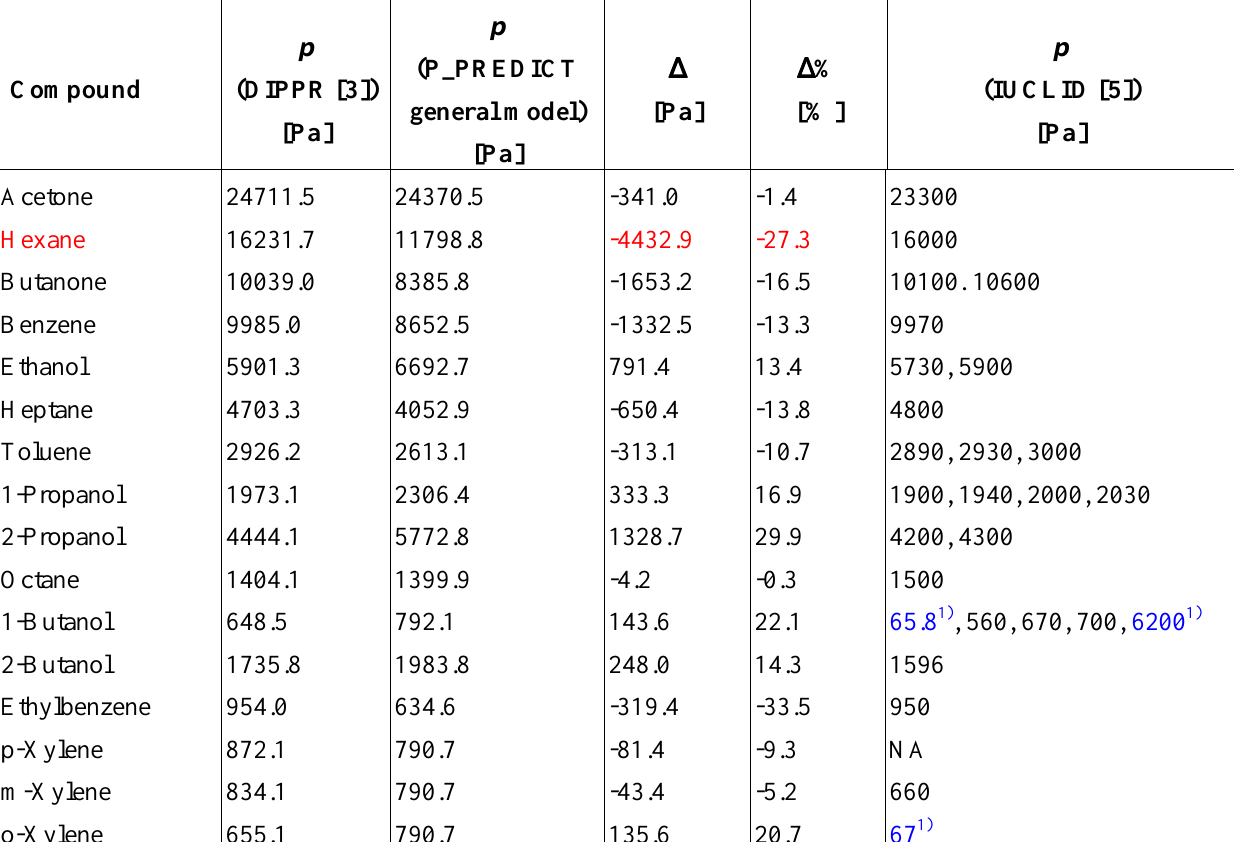
Table 5. P_PREDICT predictions versus “true” vapour pressure